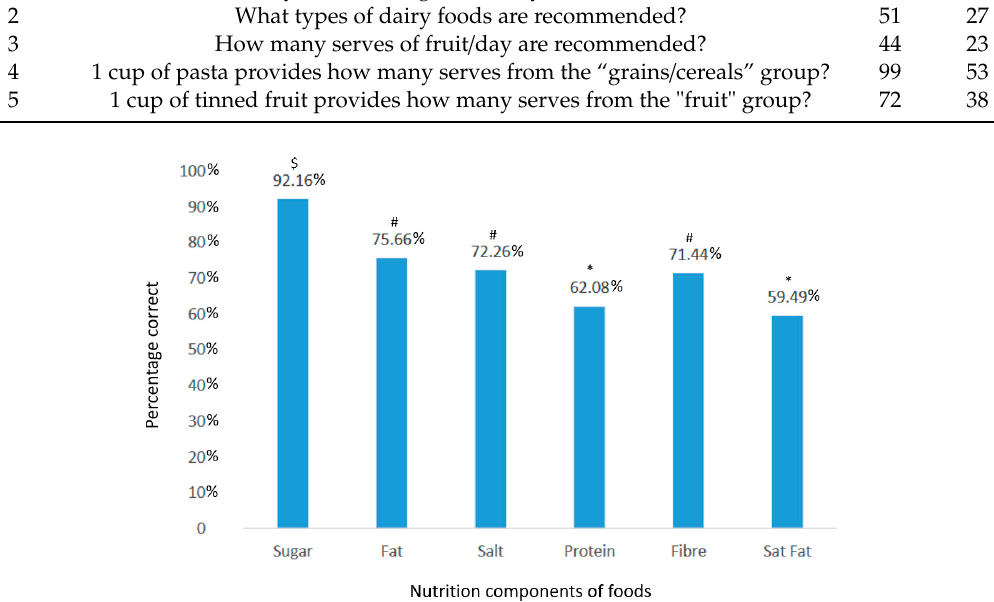
Figure 1. Percentage of correct responses for high vs. low nutrition content for specific foods (n = 188). $ = statistically significantly greater compared to fat, salt, protein, fibre and saturated fat; # = statistically significantly less compared to sugar, and greater than protein and saturated fat; * = statistically significantly less compared to sugar, fat, salt, and fibre.